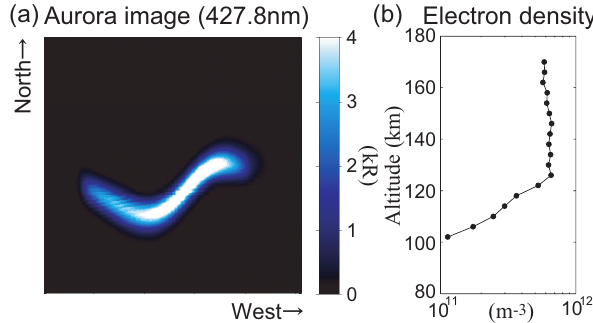
Fig. 4. (a) Auroral image at a wavelength of 427.8nm observed with CCD imager at Skibotn. Gray levels in this image include a background noise of 300R. (b) Electron density measured with the EISCAT radar at Tromsø. The electron density includes a Gaussian noise with a mean of 0m − 3 and a standard deviation of 3% of the